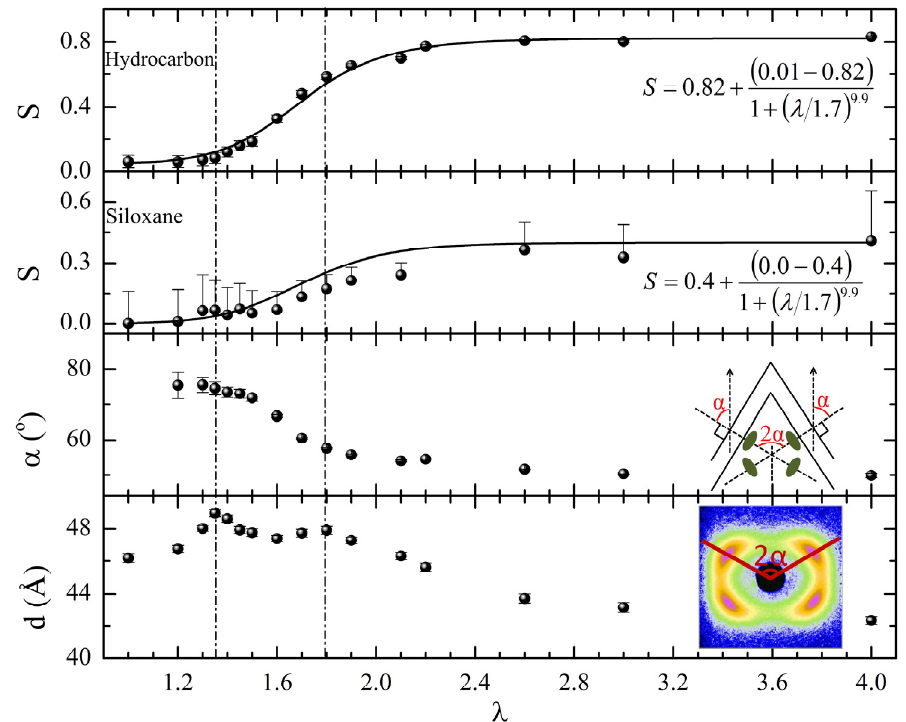
Figure 11. LCE1: Dependence of S, d and α in strain λ for LCE1. All values are calculated after ~20 min of equilibration at each strain. The dashed-dotted lines at strains of 1.35 and 1.8 serve as guide to eye separating the three elastic